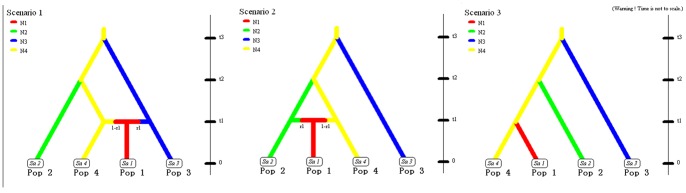
Alternative scenarios for ABC analysis.Alternative scenarios to describe the origin of the Tai for ABC analysis. Scenario 1 corresponds to the northern origin hypothesis, scenario 2 corresponds to the southern origin hypothesis and scenario 3 corresponds to the indigenous origin hypothesis. Details of the parameters used each scenario are provided in the Materials and Methods section.